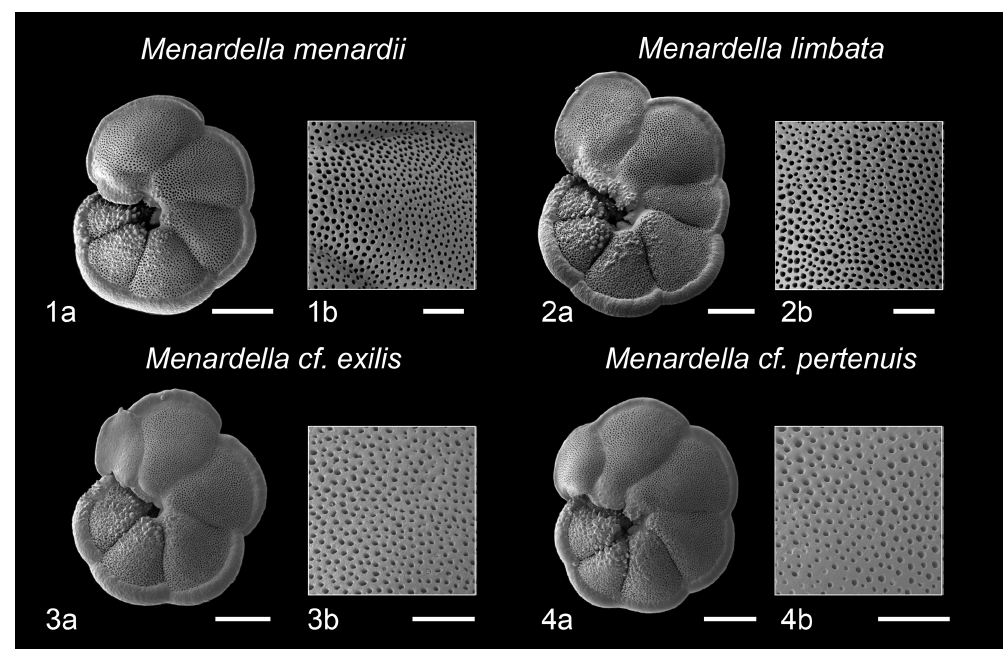
Figure 6. Scanning electron micrographs of select species of Menardella and pore detail of penultimate chambers. (1a) M. menardii , (1b) M. menardii pore detail, (2a) M. limbata , (2b) M. limbata pore detail, (3a) M . cf. exilis , (3b) M . cf. exilis pore detail, (4a) M . cf. pertenuis , (4) M . cf. pertenuis pore detail. Scale bar for images (1a) , (2a) , (3a) , (4a) = 200 microns, for image (1b) , (2b) , (3b) , (4b) = 50µm. Specimens 1 and 2 from sample U1338A-5H-CC-11/14 and specimens 3 and 4 from sample 1338A-5H-7W-76-79.